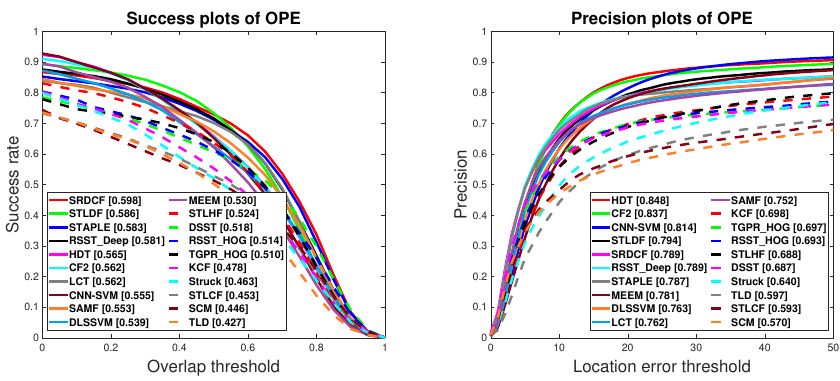
Figure 3. The overall OPE plots for 100 frame sequences in OTB100.